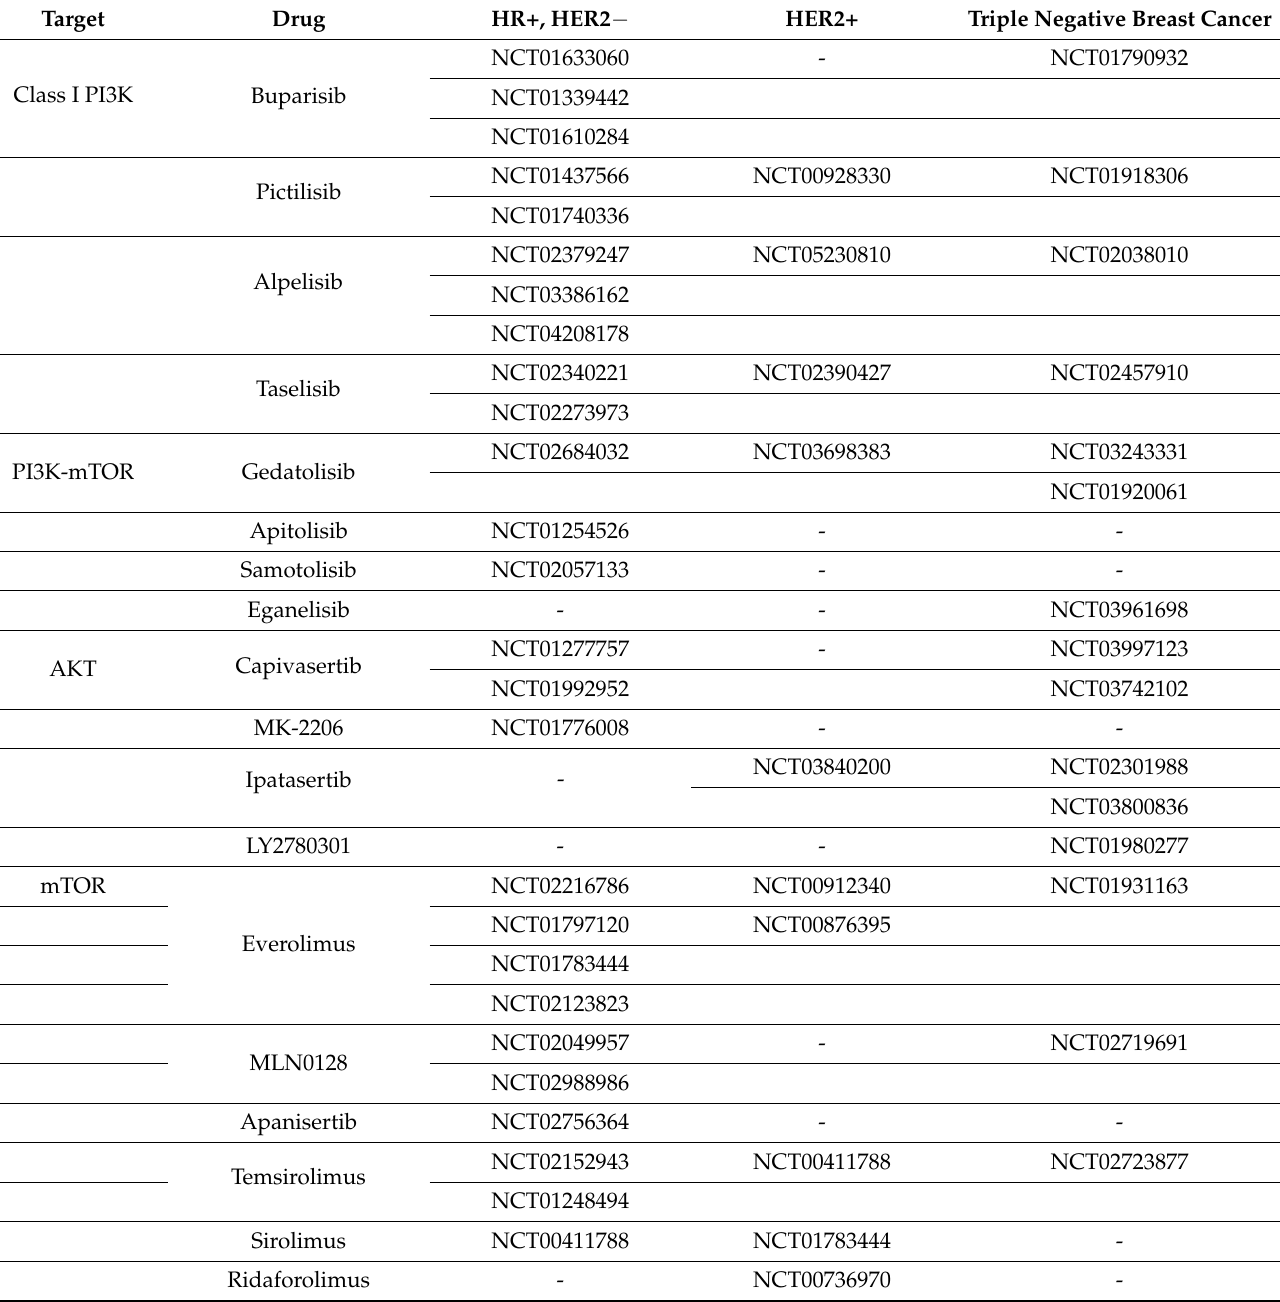
Table 6. Lists of clinical trials of some PAM inhibitors in different subtypes of breast